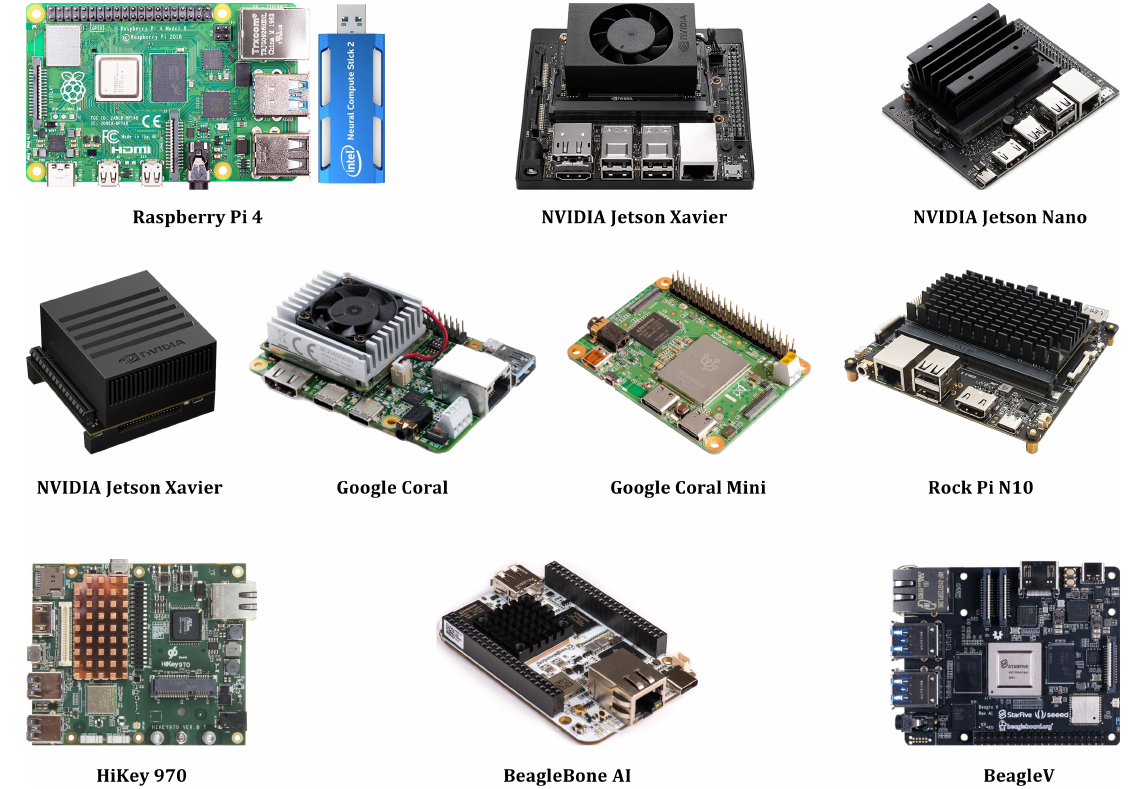
Figure 12. Some well-known Development Boards for DL